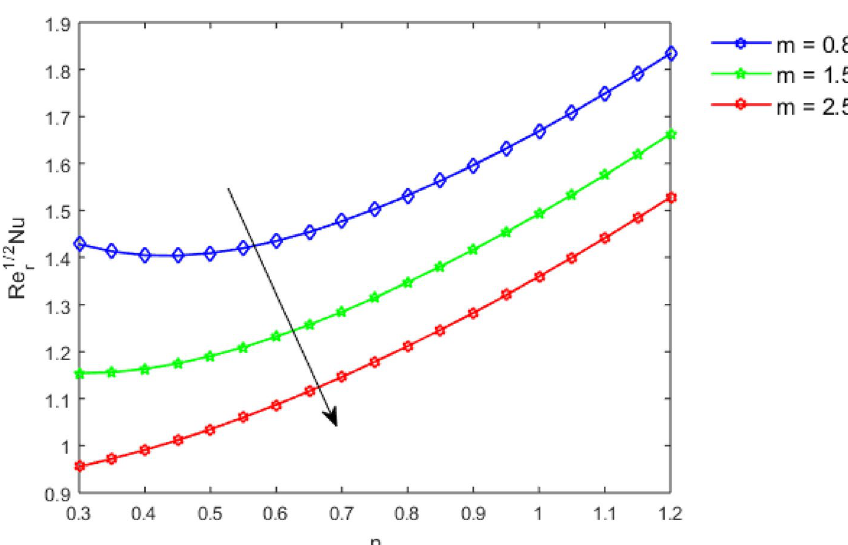
Figure 19. Heat transfer rate by increasing m , for n < 1, n = 1 and n > 1 , r = 0.6, Pr =